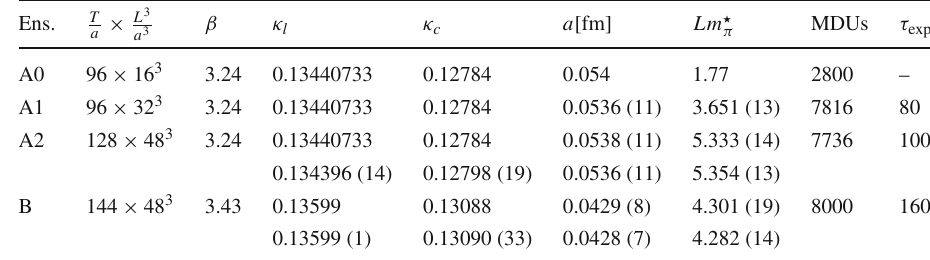
Table 2 Simulation parameters, lattice sizes and statistics of the three ensembles, the second row values for ensembles A2 and B are shifted to the correct tuning points φ 4 and φ 5 , using the strategy described in Sect. 3.3, Eq. (3.20)